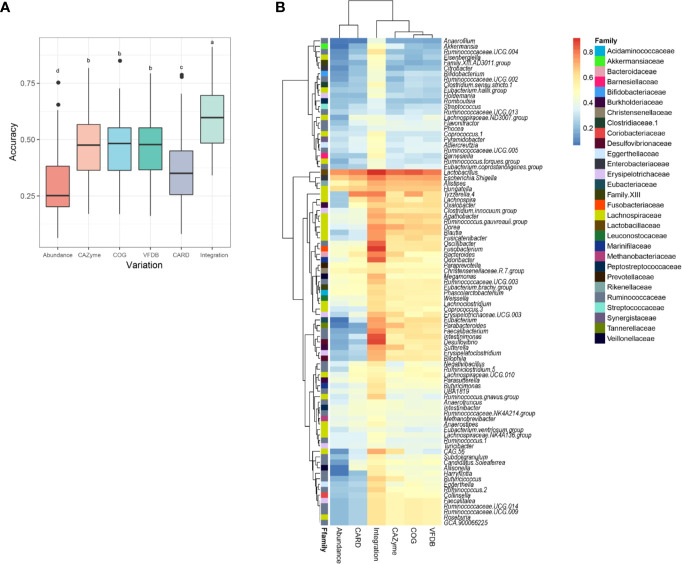
Correlation analysis between L. plantarum functional genomes and their influences on intestinal flora. (A) Boxplot for the accuracy scores of predicting the variation in microbiome using different functional genes. (B) Heatmap for the accuracy scores of predicting the variation in each genus using different functional genes. Labels of a, b, c, and d in the boxplot represent significant differences at p < 0.05.